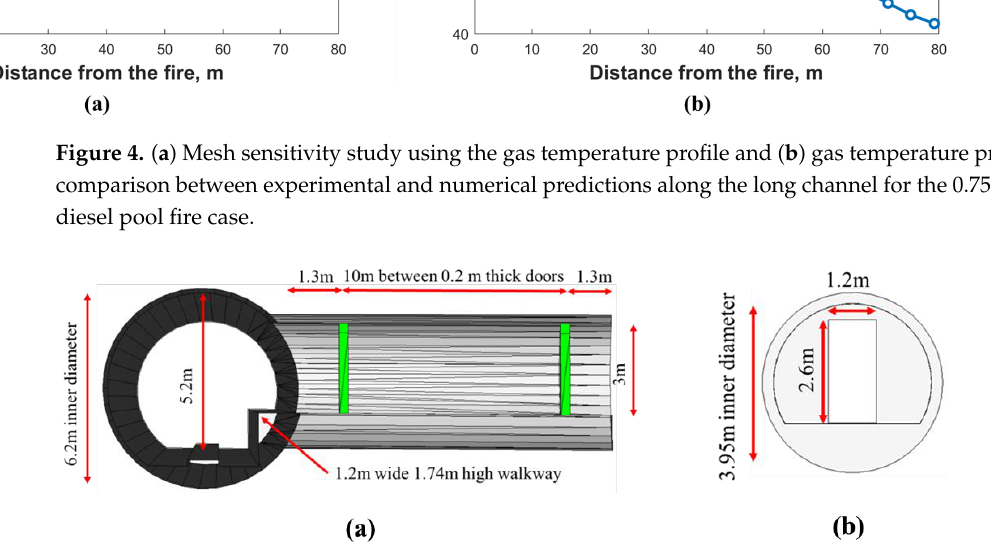
Figure 5. Geometry configuration and dimensions of ( a ) rail tunnel and cross-sectional view of ( b ) the cross-passage.